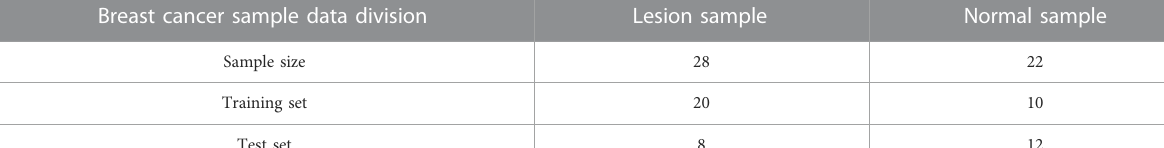
TABLE 2 Basic description of sample data.